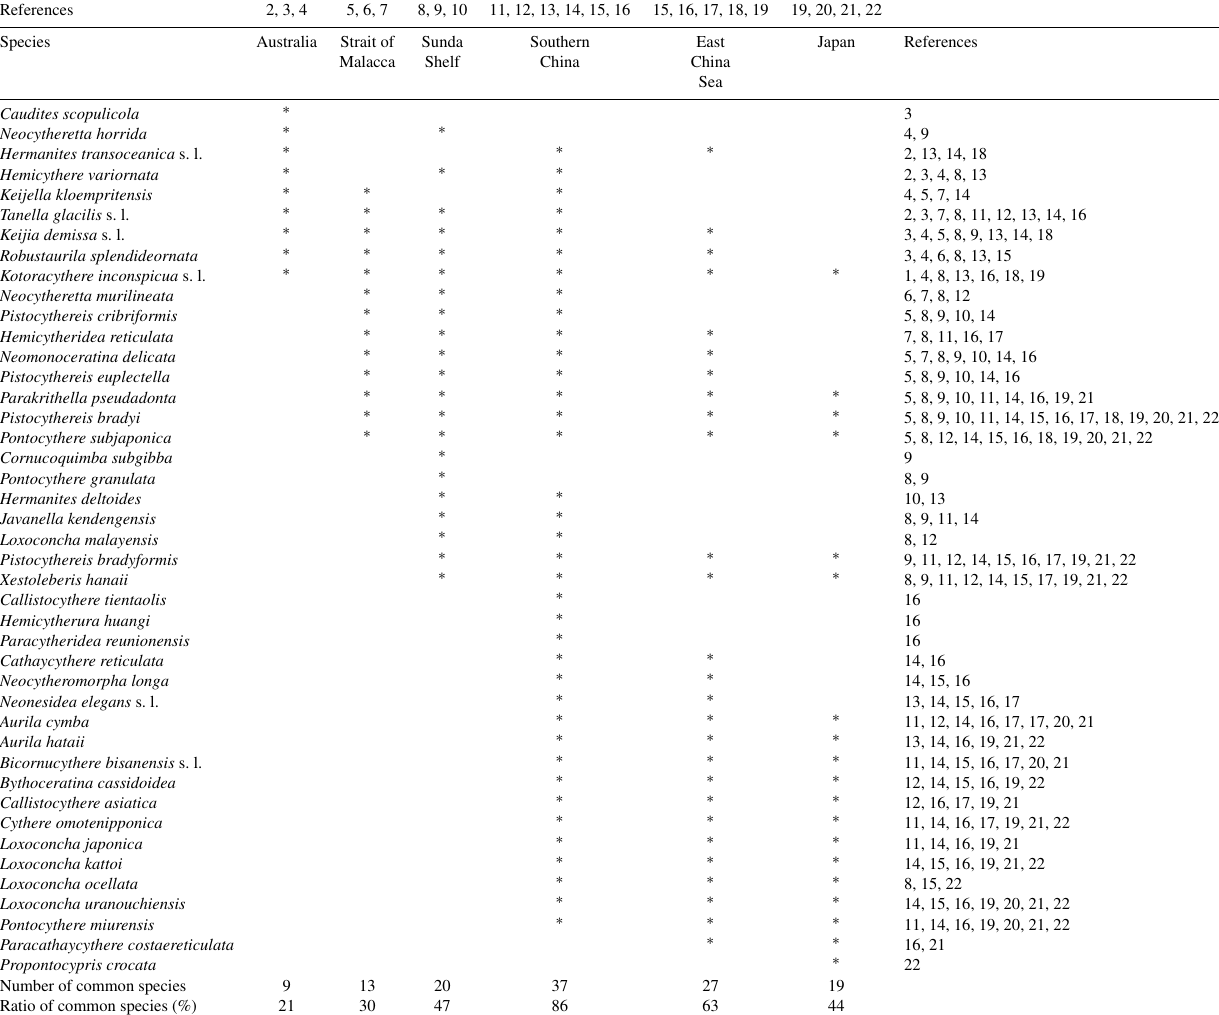
Table 3. Biogeographical distribution of the 43 species detected in the Co To